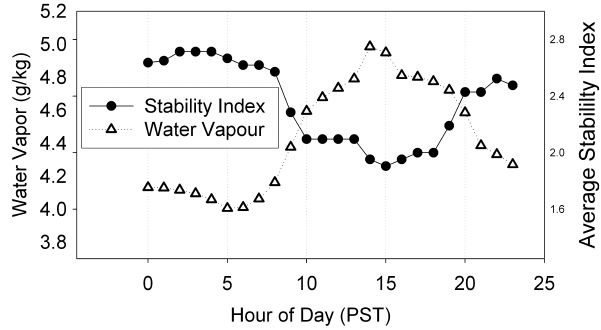
Fig. 1. Diurnal variation in water vapour and stability at Whistler Peak for May 2006. The stability Index of 3 describes stable condi- tions and 1 is unstable or assumed mixed